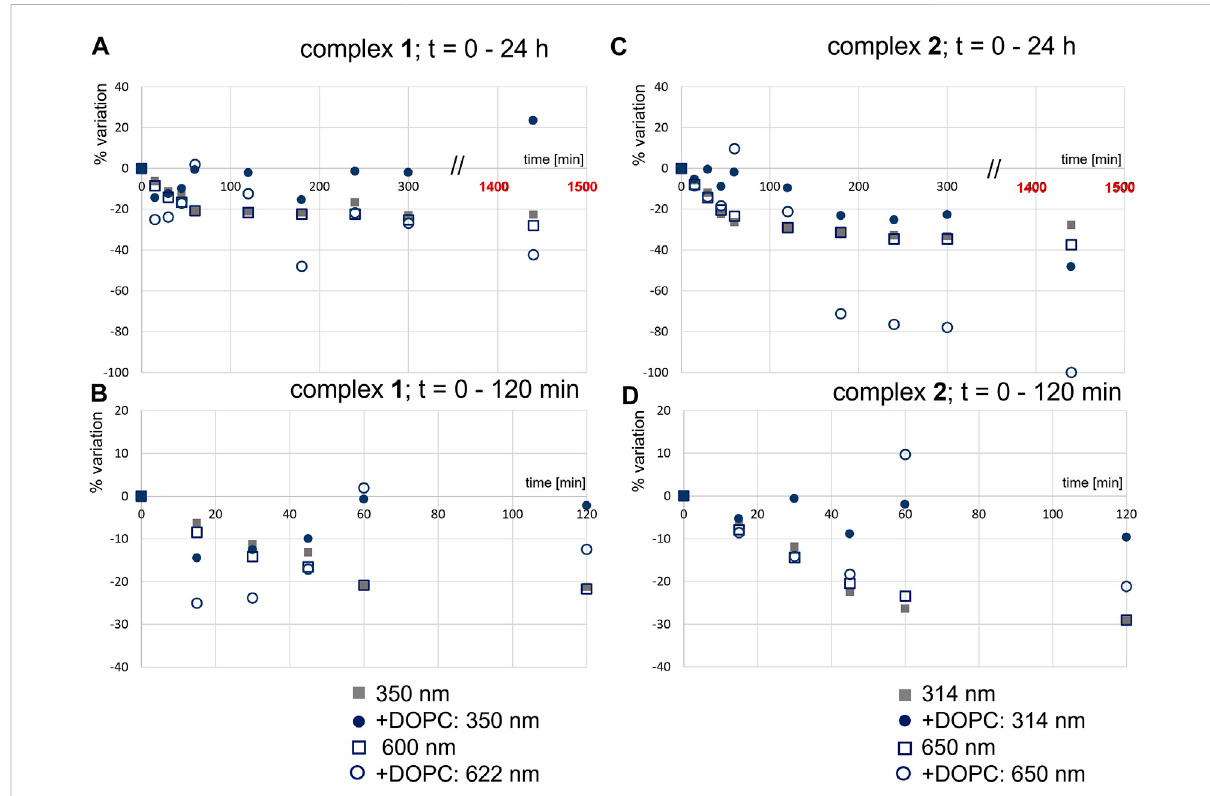
FIGURE 2 EffectofDOPCLUVsonthestabilityof 1(A and B) and 2(C and D) :variationinabsorbance(%)attheindicatedwavelengths,intheabsence(c 1